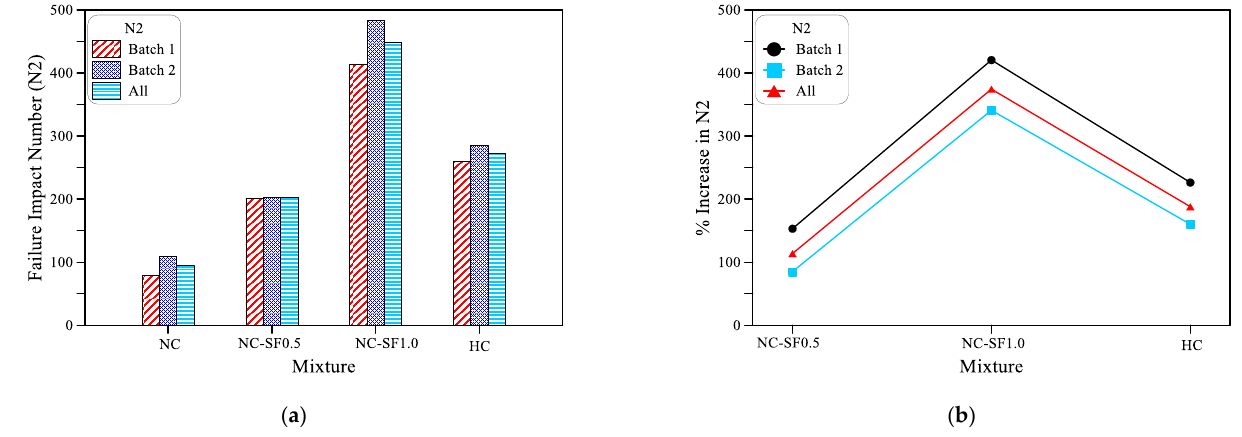
Figure 6. Impact results at failure stage ( a ) N2 records of all mixtures ( b ) percentage increase in N2 of the fibrous and HC mixtures compared to the NC